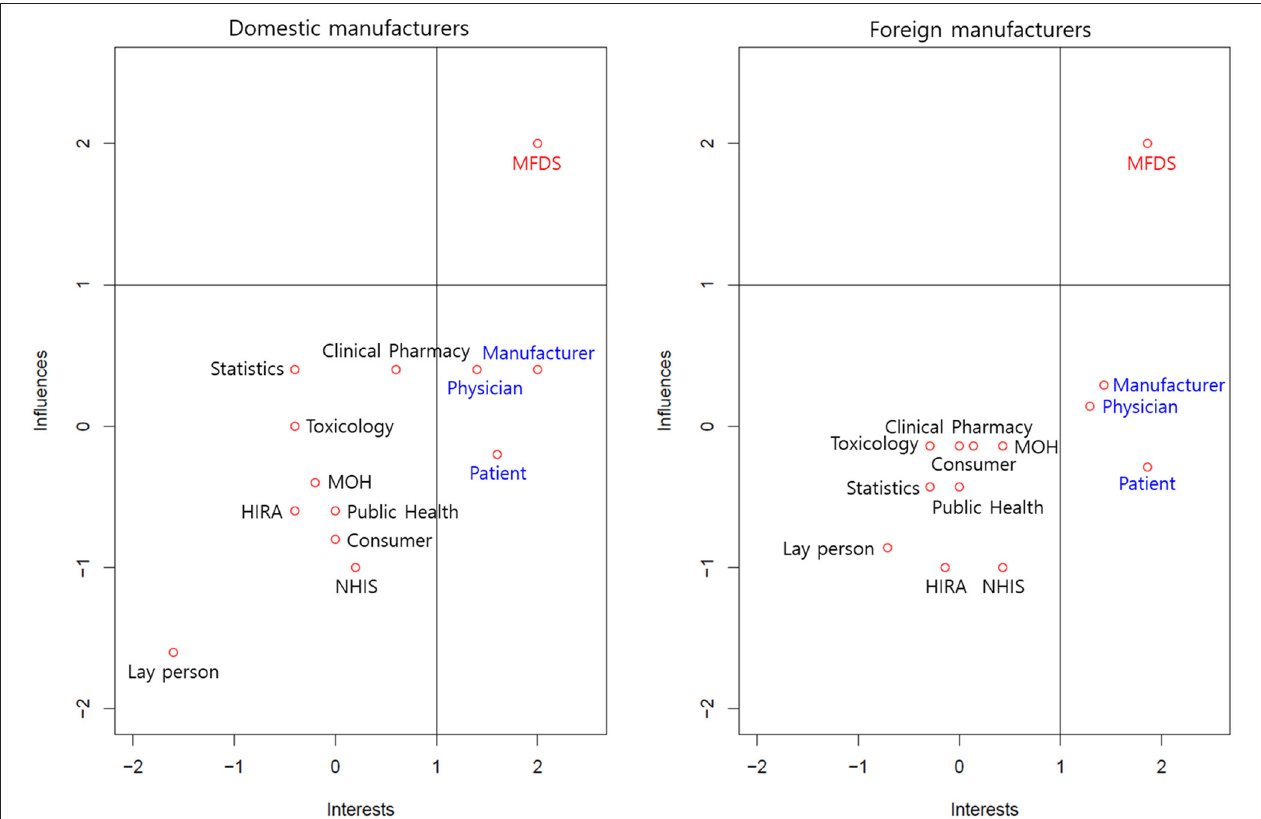
FIGURE 1 | Interests and influences of various stakeholders in regulatory decisions. MFDS, Ministry of Food and Drug Safety; HIRA, Health Insurance Review and Assessment Service; NHIS, National Health Insurance Service; MOH, Ministry of Health and Welfare.